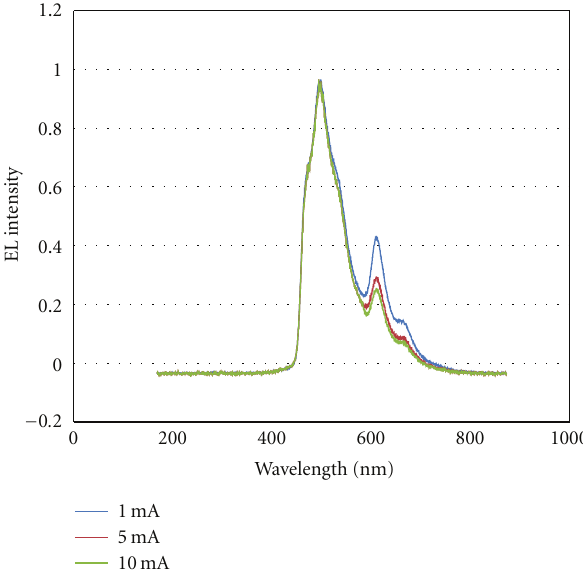
Figure 12: EL spectra in sample F. Injected currents are 1, 5, and 10mA.